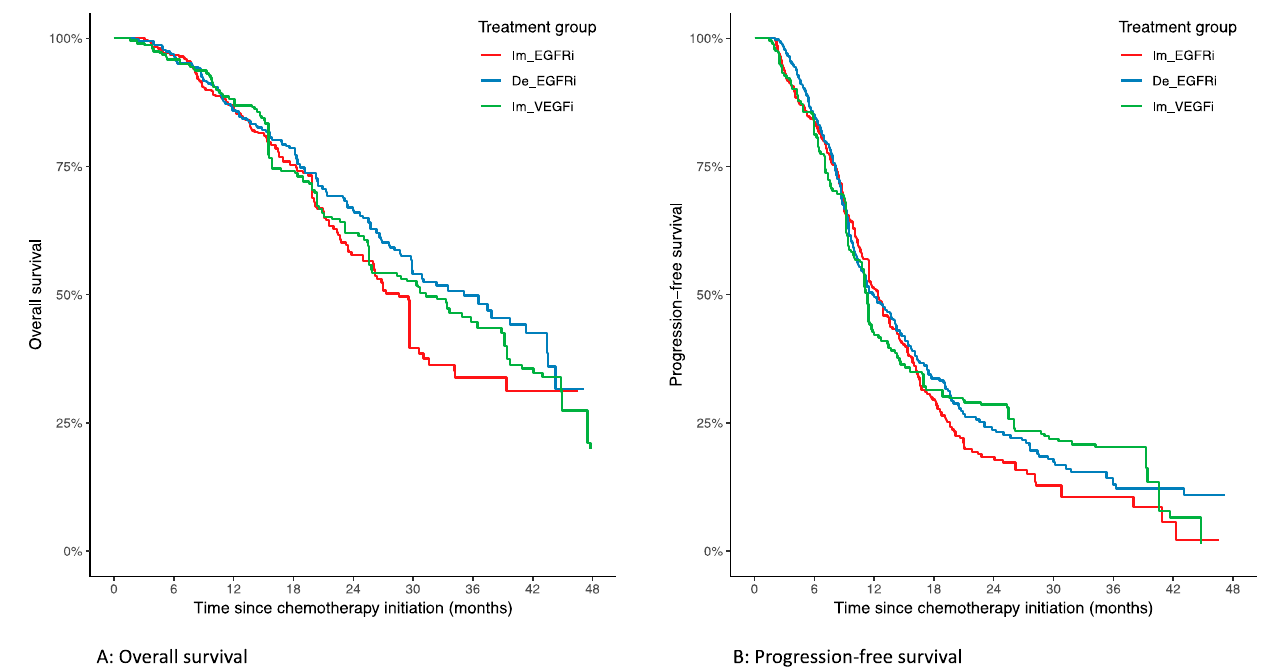
Figure 2. Survival according to treatment groups in the weighted study population. ( A ) Overall survival; ( B ) progression-free survival. Im_EGFRi = immediate anti-EGFR; De_EGFRi = delayed anti-EGFR; Im_VEGFi = immediate anti-VEGF. Table 3. Regression models in the weighted study population. Cox